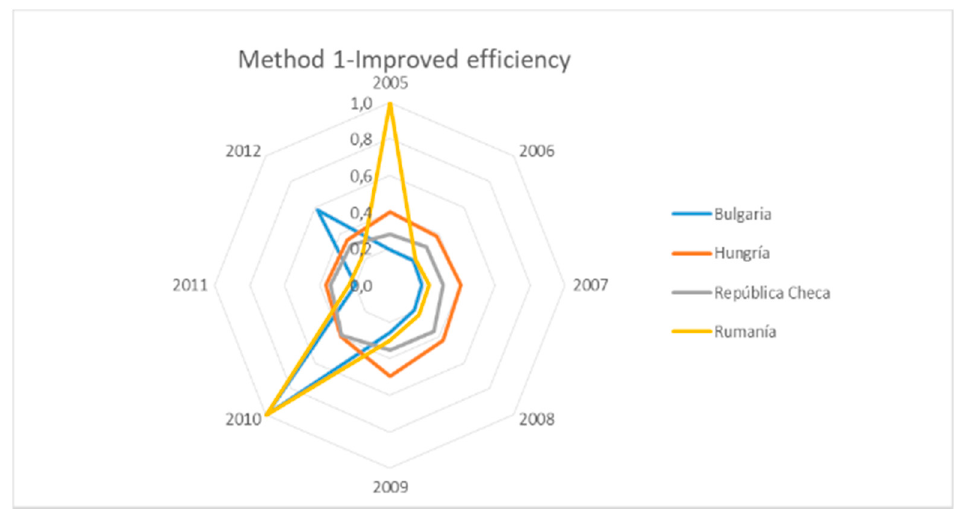
Figure 8. Variation in environmental efficiency in the years 2005–2012 with the DEA Method 1 and for Method 2 for the 14 countries in the category “Average environmental efficiency”. Source: self